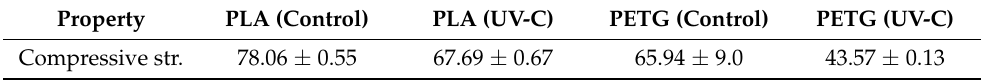
Table 4. Compressive